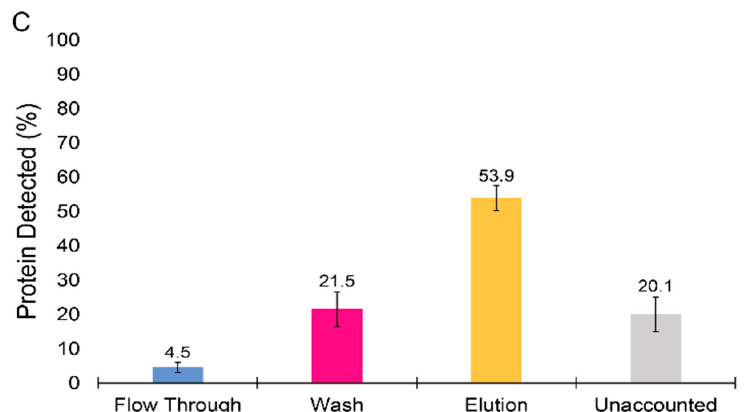
Figure 3. Assessment of selectivity and robustness of the GPRPFPAWK affinity column purification for Peak 1 fibrinogen. ( A ) Western blot showing fibrinogen before and after running over the GPRPFPAWK affinity column. Lane labels are as following: Ladder (L; kDa), the pre-column load- ing (Pre), and fractions from the column flow through (PF1–3), washes (W1–5), and elutions (E1–5). ( B ) Western blot showing fibrinogen before and after running over the RPGPFAWPK, scramble peptide column. Lane labels are the same as in ( A ). ( C ) Bar chart showing the average fibrinogen yields off the column over 9 separate runs with standard error bars shown.